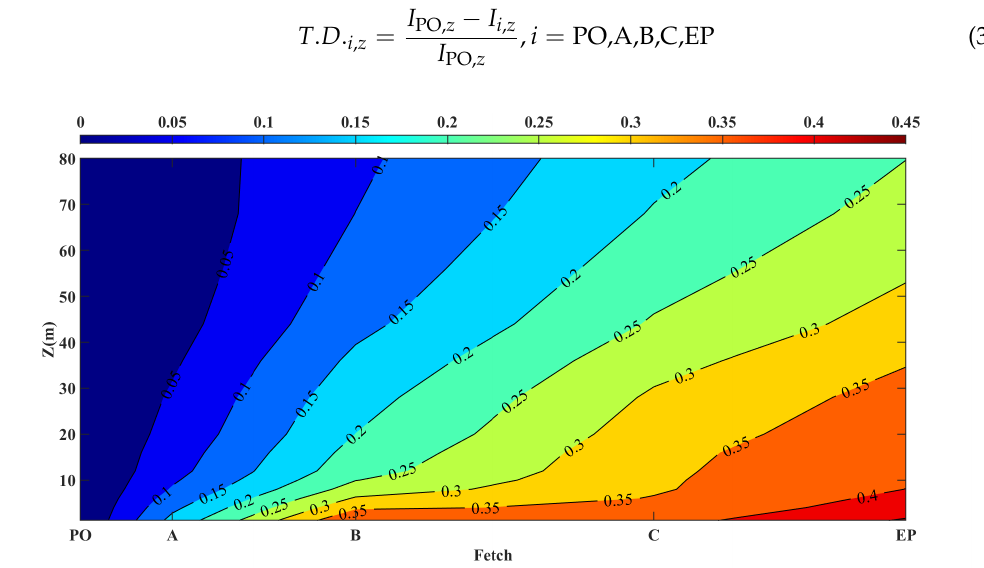
Figure 4. Turbulence decay of generic profile from point of origin (PO) to end point